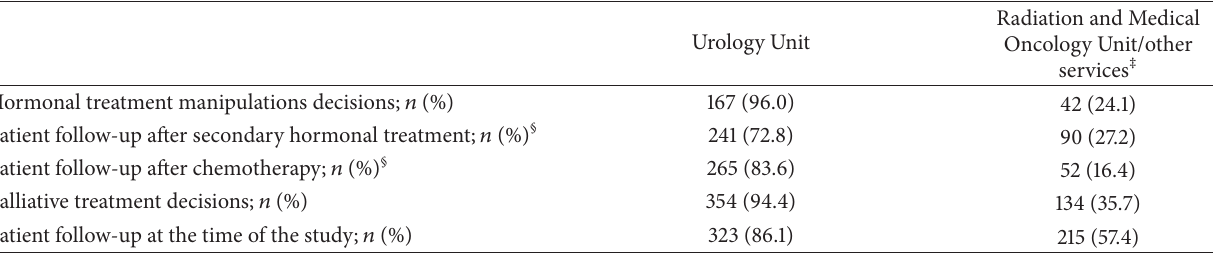
Table 4: Specialists involved in the therapeutic decision-making process †